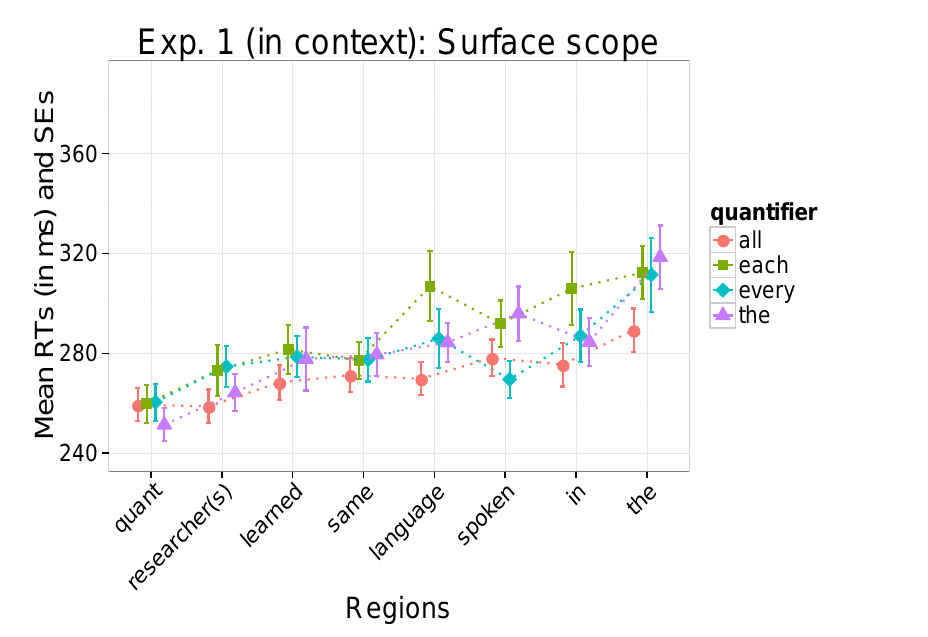
Figure 2 Mean RTs and SEs for all ROIs in Experiment 1 (in context); surface scope